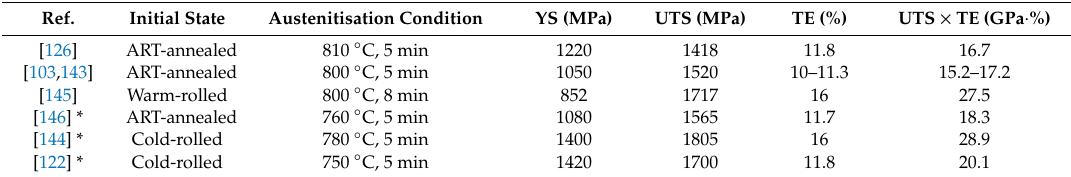
Table 2. Reported tensile properties of some low-temperature hot stamped MMn steels. Ref.